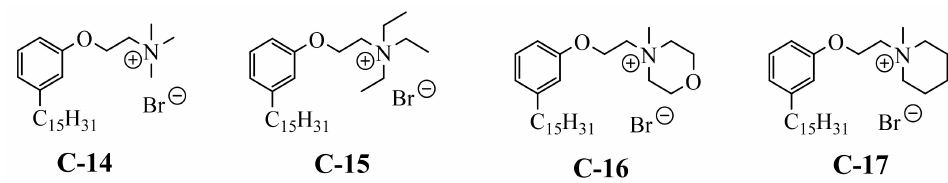
Figure 5. Ammonium surfactants prepared from hydrogenated